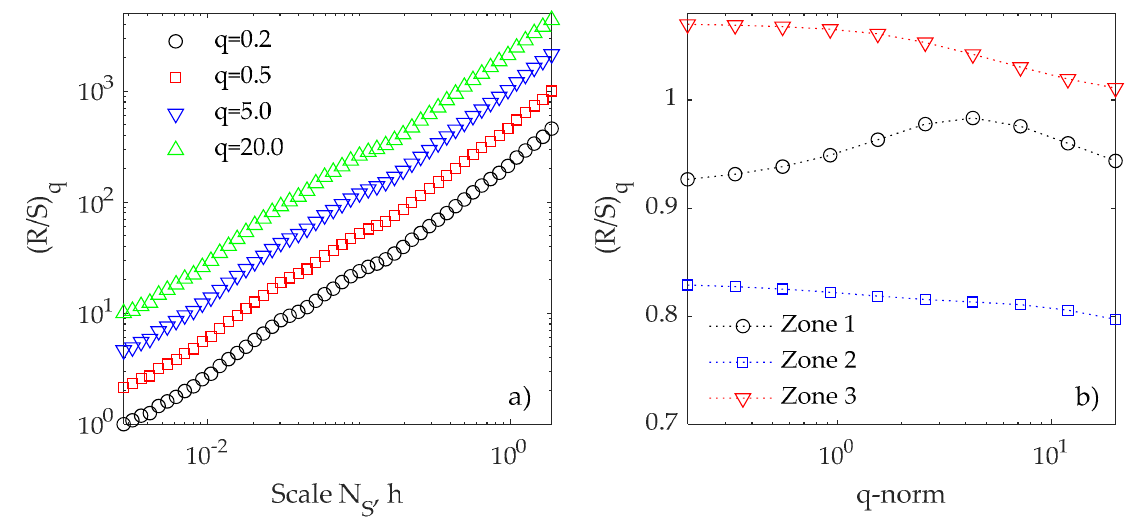
Figure 8. Multifractal analysis for pH time series to pH = 7.5 and T = 40 °C, ( a ) R / S analysis applied to different q-norm and ( b ) H q as a function of q-norm.